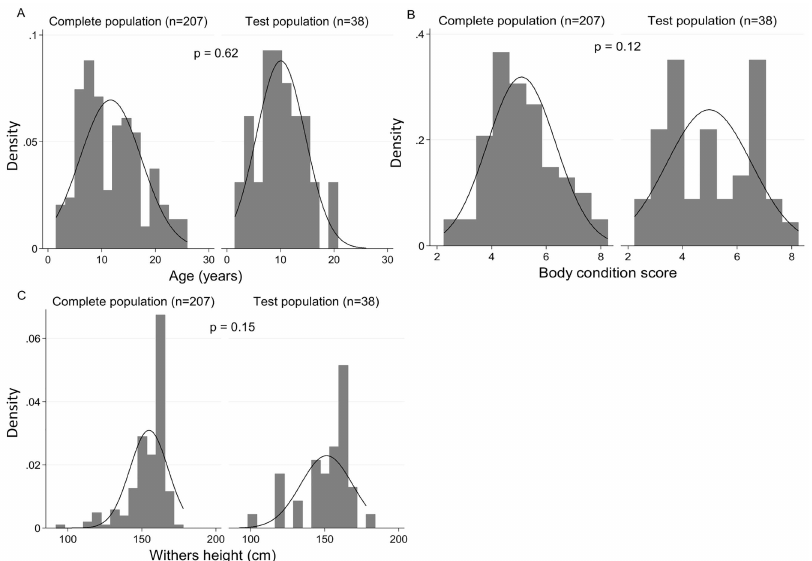
Fig 2. Population distributions of age, BCS and withers height in the test animals ( n = 38) and the population in which they were nested (n = 207). Histograms were constructed with normal distributionline overlaidfor age (A), body conditionscore (B) and withers height(C). Paired Students T-test was used to identify any differences betweenthe